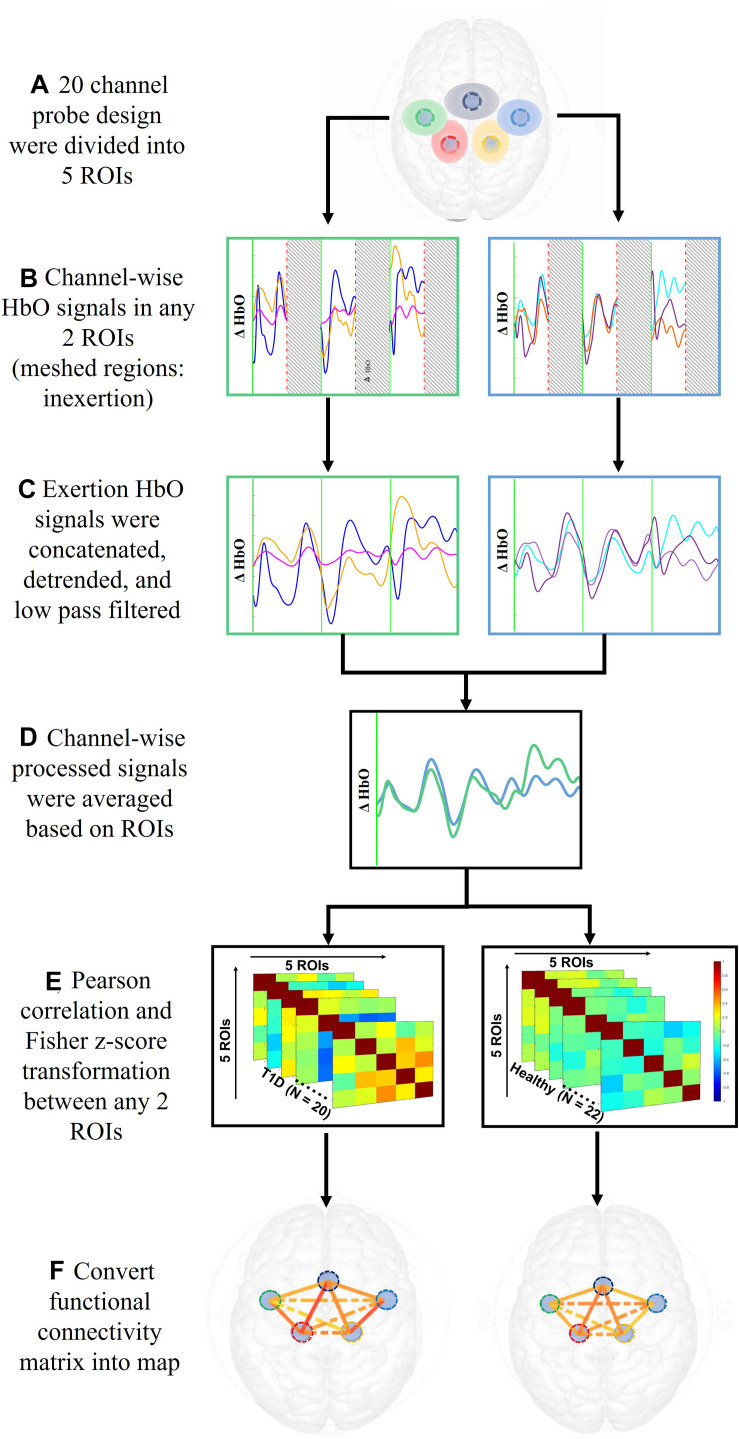
Data analysis steps performed on ρHbO signals from the period of fatigue test to the calculation of functional connectivity.